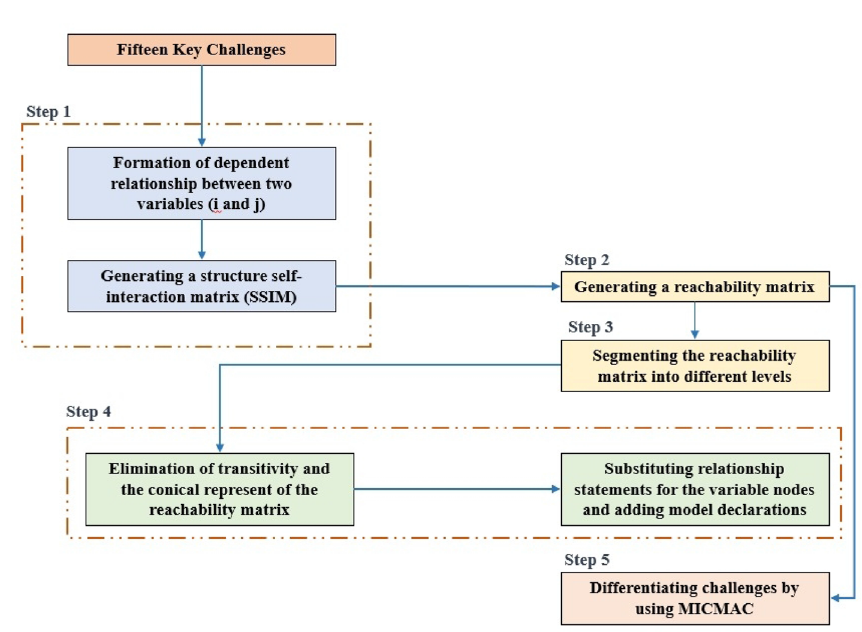
Figure 1. Methodology and process of ISM